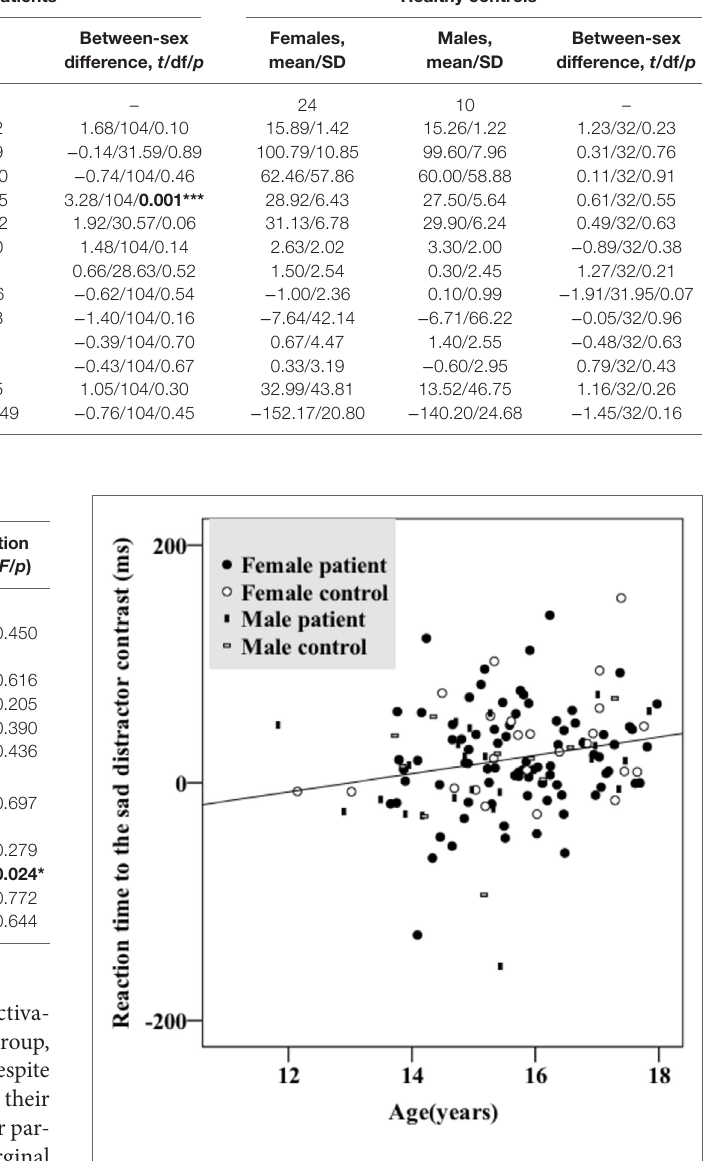
FigUre 2 | Older participants had longer reaction times responding to the sad distractor contrast. There were no significant group (depressed/healthy) or sex effects. Female patients, female controls, male patients, and male controls all showed similar patterns.